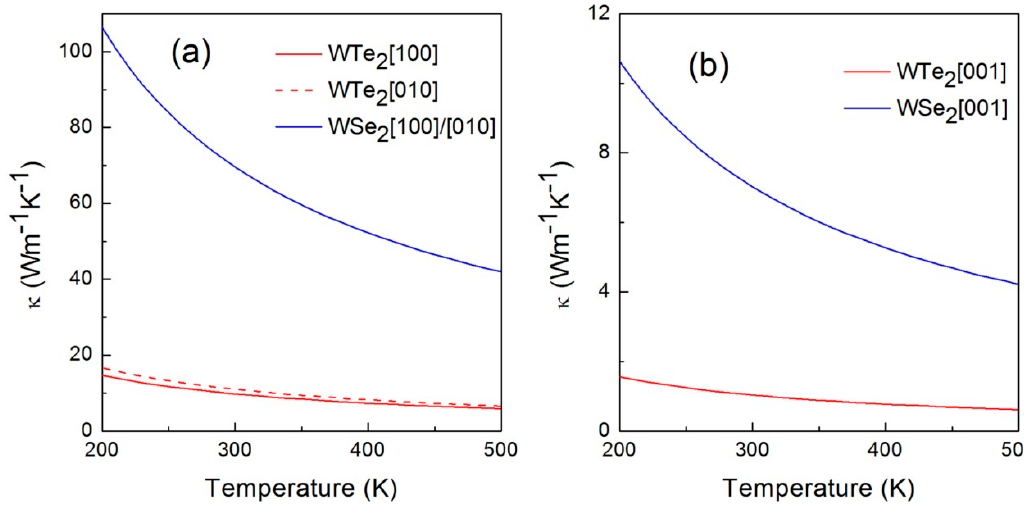
Figure 7. ( a ) The thermal conductivities of WTe 2 and WSe 2 along the [100] and [010] directions from 200 K to 500 K; ( b ) The thermal conductivities of WTe 2 and WSe 2 along the [001] direction from 200 K to 500 K [51].